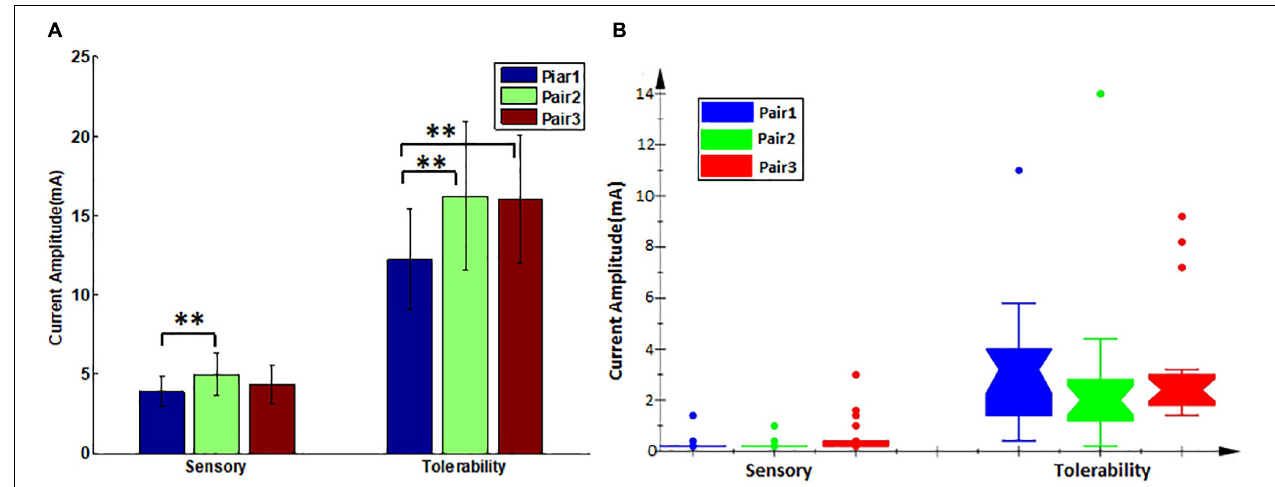
FIGURE 4 | The sensory and tolerability threshold comparisons between the pairs. (A) Transcutaneous electrical nerve stimulation (TENS) thresholds, error bars denote the mean and standard deviation of the data, ∗∗ ( p < 0.01). (B) Electroacupuncture (EA) thresholds, its lower and upper boundary lines are the 25%/75% quantile of the data, outliers are also marked on the